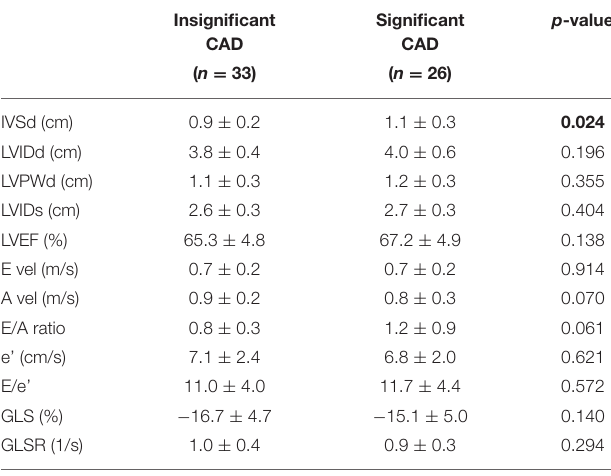
TABLE 2 | Comparison of conventional echocardiographic measurements in the insignificant CAD and significant CAD groups. p Insignificant Significant CAD CAD